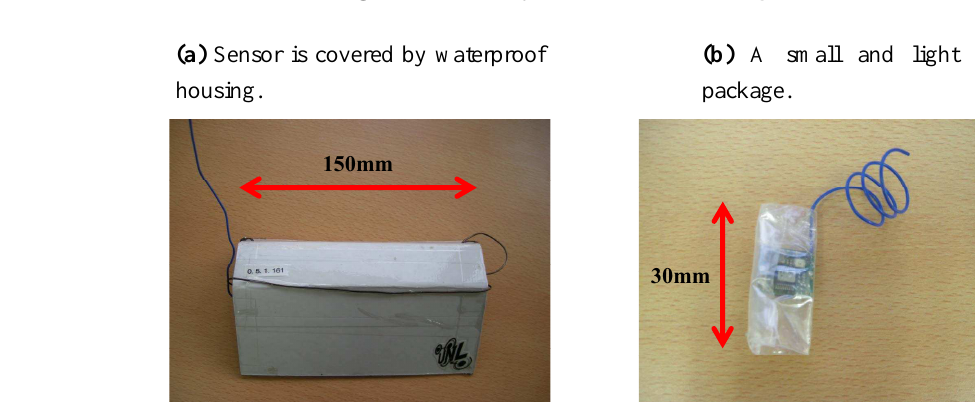
Figure 4. Two types of uPart